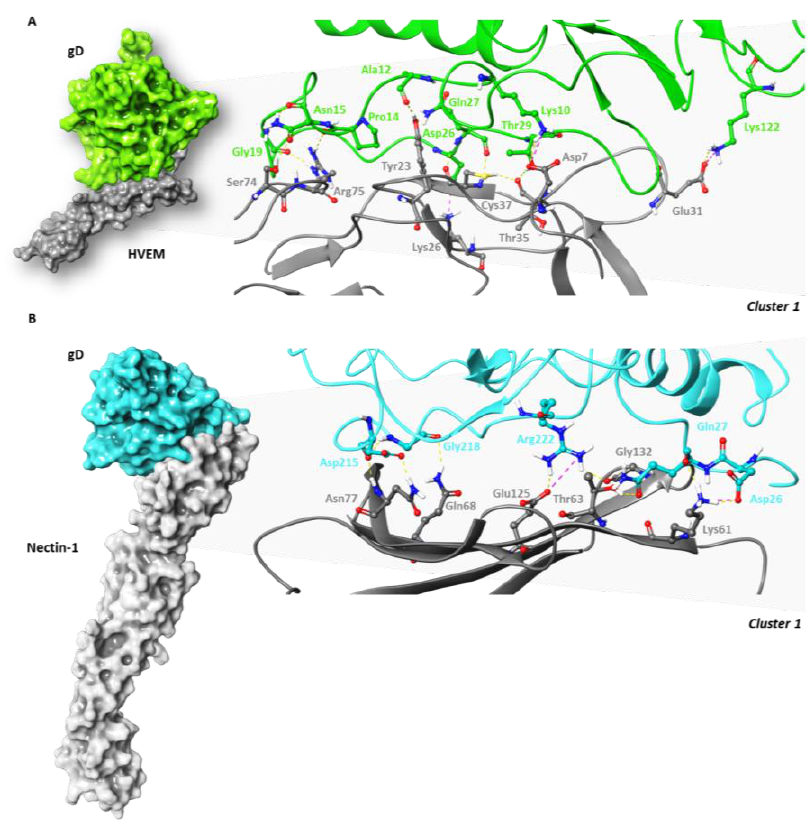
Figure 2. Surface representation of ( A ) gD-HVEM and ( B ) gD-Nectin-1 complexes and focus on the interface with key interactions labelled and displayed in carbon sticks.